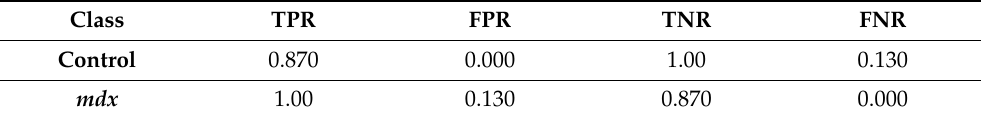
Table 1. Example of the results of external validation. TPR: true positive rate; FPR: false positive rate; TNR: true negative rate; FNR: false negative